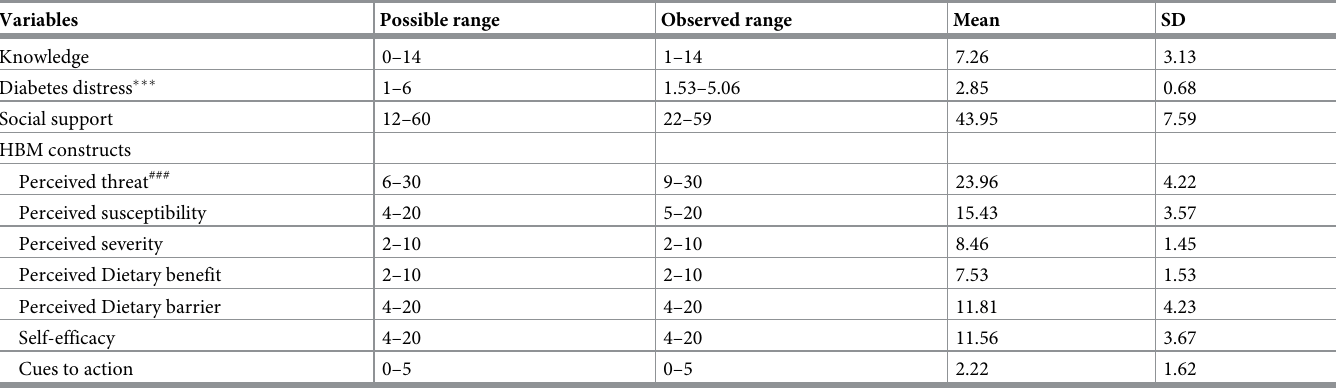
Table 3. Psychosocial characteristics of diabetic patients in JUMC, 2020.